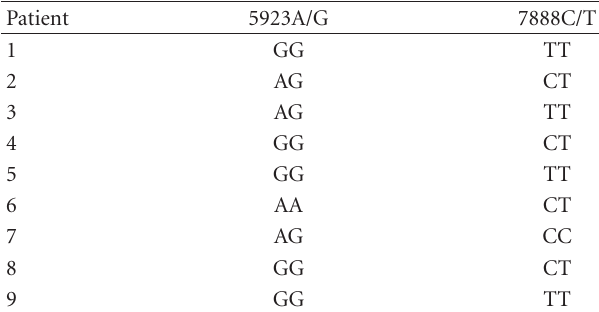
Table 3: Genotype distribution of 5923A/G and 7888C/T polymor- phisms from AICDA gene in our